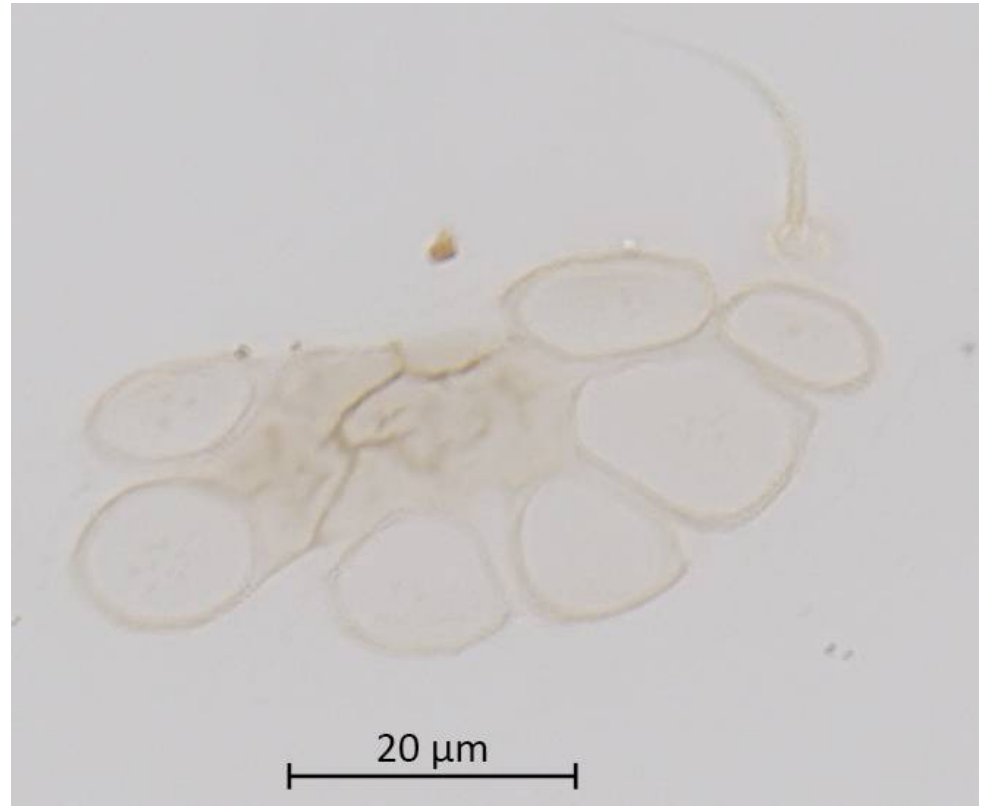
Figure 9. Dorsal abdominal wax gland and single seta of alate vivipara of Qiao jinshaensis sp. nov. (IOZ(E)54810). Table 3. Measurements (in μm) of alate viviparae (n = 14) of Qiao jinshaensis sp. nov.